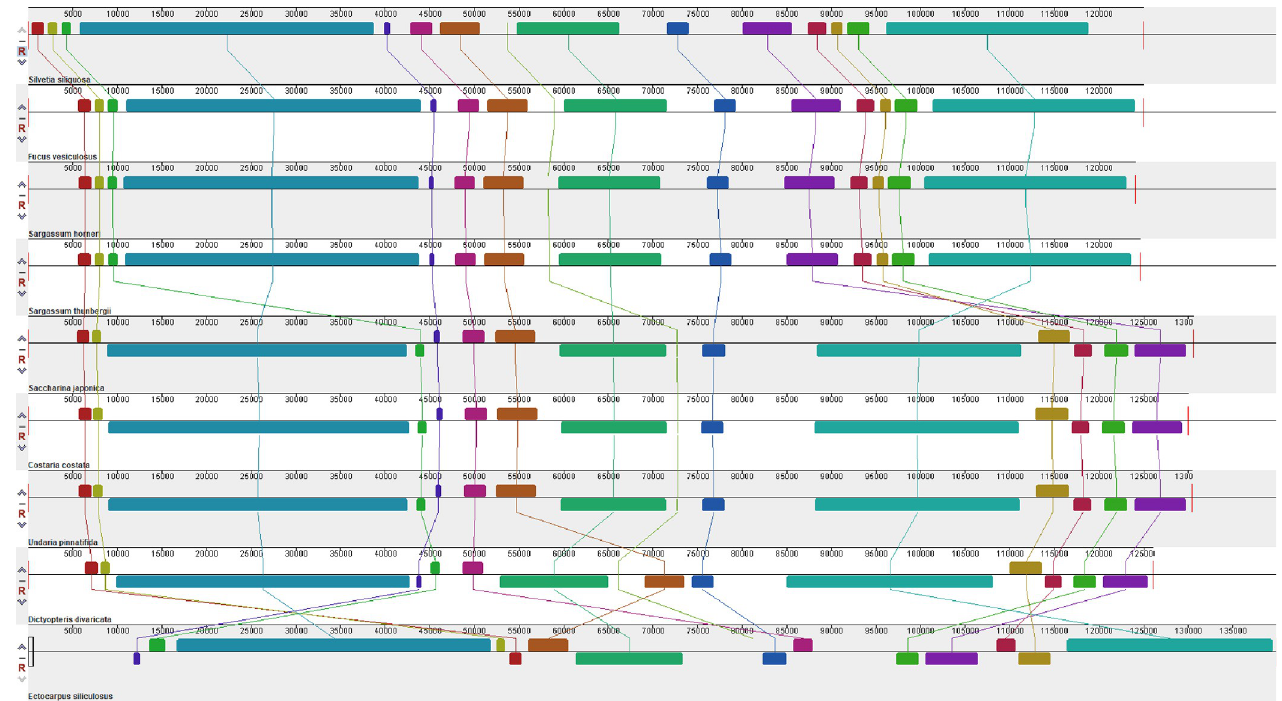
Fig 6. The collinearity analysis of Phaeophyceae chloroplast genomes. https://doi.org/10.1371/journal.pone.0269631.g006 PLOS ONE | https://doi.org/10.1371/journal.pone.0269631 June 16,